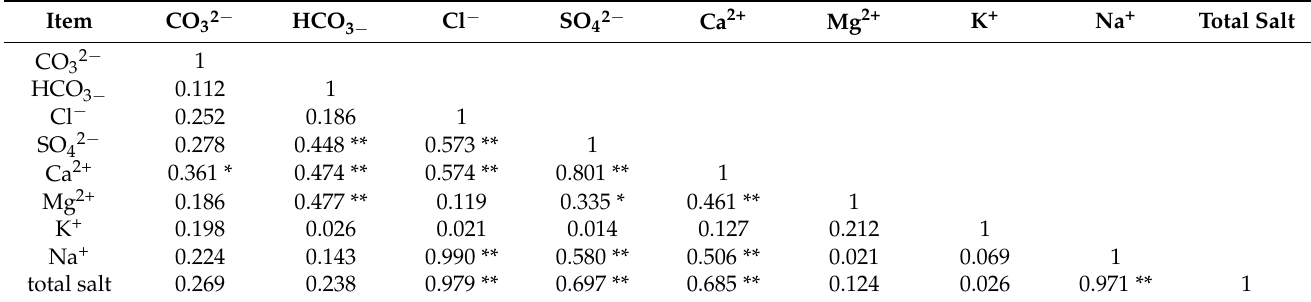
Table 3. Correlation coefficients between total salt and eight major ions in Area